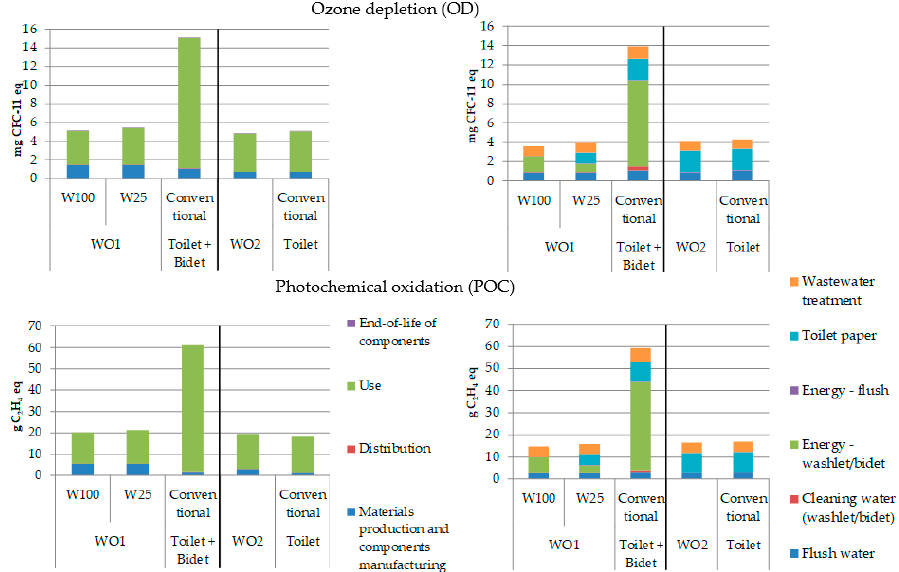
Figure 3. LCIA results of the alternative toilet systems (WashOne and conventional toilet system) per family × year: ( a ) LC impacts and ( b ) use phase impacts breakdown.